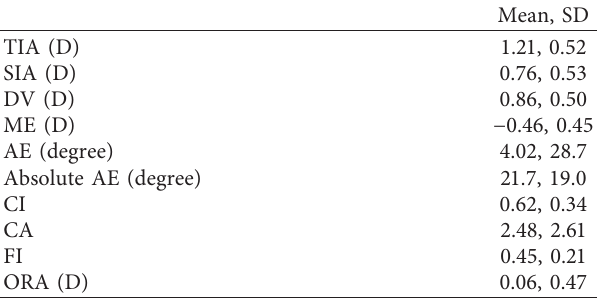
Table 3: Outcomes of vector analysis via the comparison of the preoperative with the postoperative values measured by the